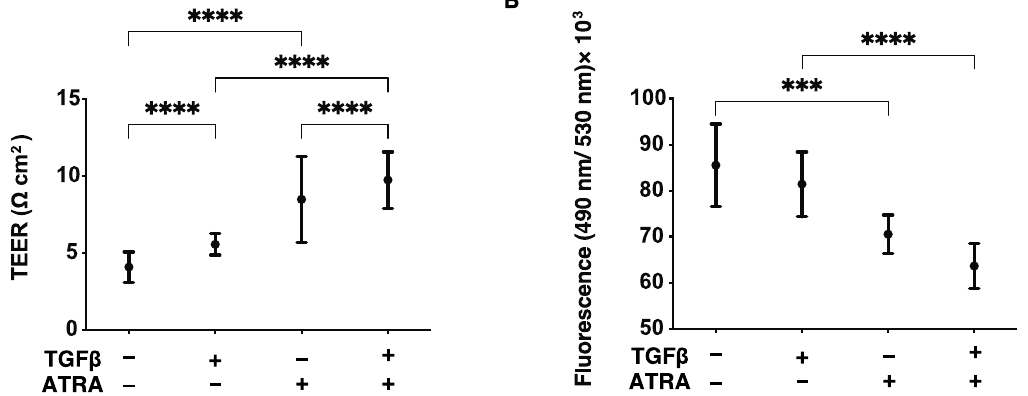
Figure 1. Effects of barrier functions of TGF- β 2 untreated or treated HconF 2D monolayers. HconF cell 2D monolayers treated with TGF- β 2 (TGF β , 5 ng/mL) and untreated monolayers were subjected to analyses of TEER and FITC dextran permeability as their barrier functions in the absence or presence of 1 µ M ATRA. Plots of the electric resistance ( Ω cm 2 ) by TEER and the absorbance of the permeated fluorescein are shown in panels ( A , B ), respectively. Experiments were repeated in triplicate ( n = 5 each). All data are expressed as the mean ± the standard error of the mean (SEM). *** p < 0.005 and **** p < 0.001; ANOVA followed by a Tukey’s multiple comparison test.